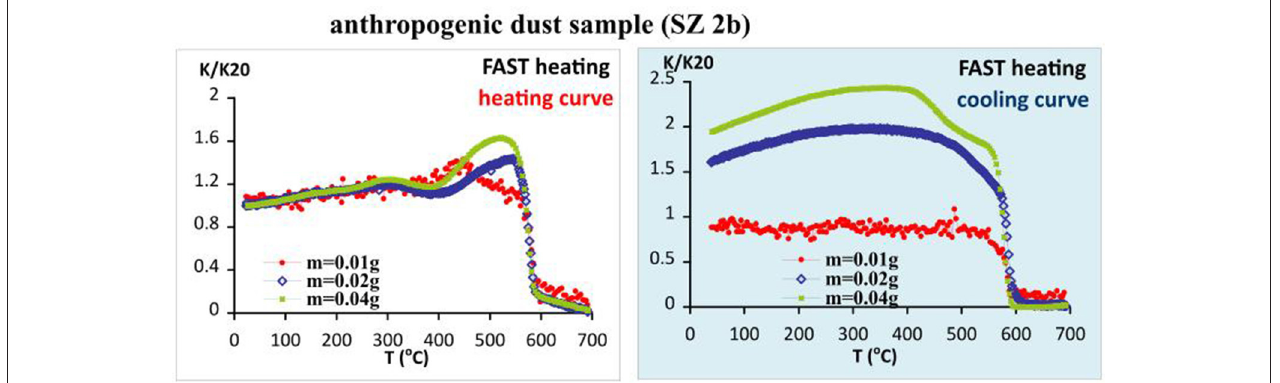
FIGURE 10 | Differences in the shape and observed transformations on thermomagnetic curves for sample SZ 2b, caused by different sample size.